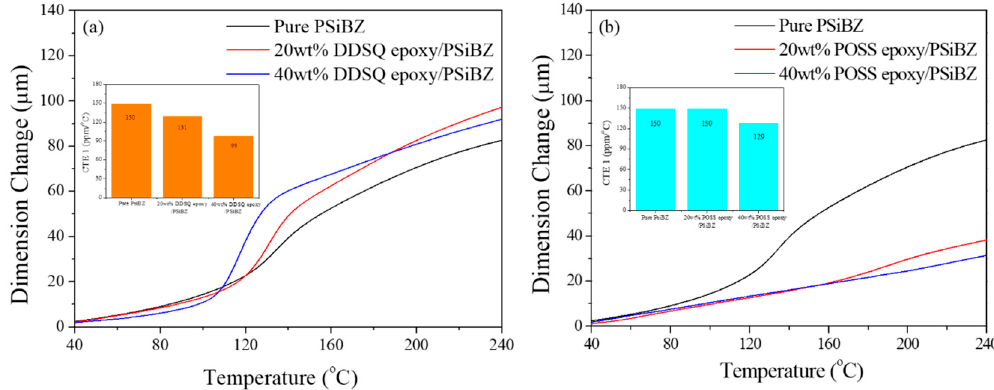
Figure 5. ( a ) Dimension change and coe ffi cients of thermal expansion (CTEs) of the DDSQ epoxy / PSiBZ nanocomposites and ( b ) dimension change and CTEs of the POSS epoxy / PSiBZ epoxy